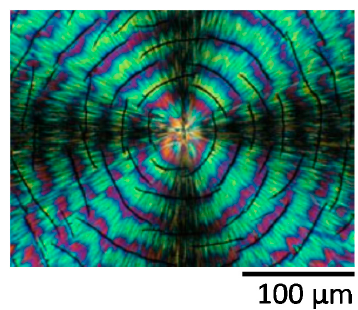
Figure 15. Polarized light micrograph showing cracks and ring bands in PTT spherulite isothermally crystallized at 195 °C and cooled/dipped in solvent. Film thickness is about 20 μ m. Reprinted by permission from Macmillan Publishers Ltd Ref. [45], copyright (2008).